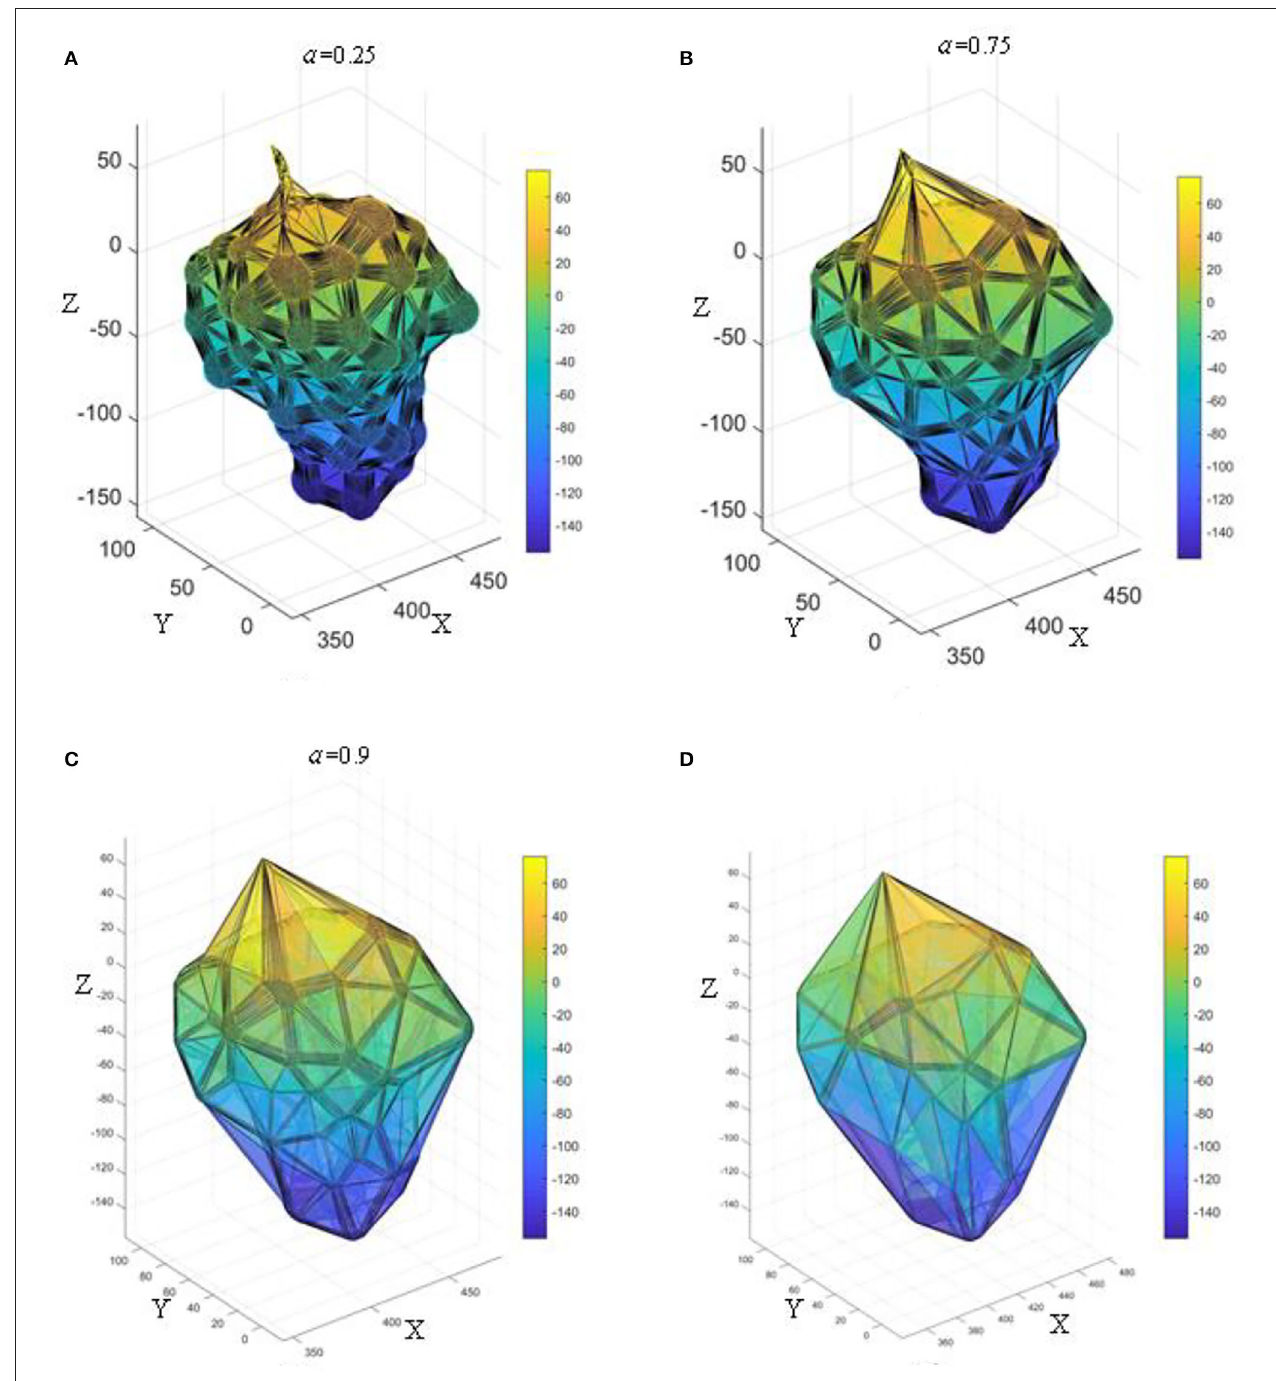
FIGURE 12 | The effect of different α -values on the reconstruction of 3D α -shape; (A) α = 0.25; (B) α = 0.75; (C) α = 0.9; (D) 3D convex hull.